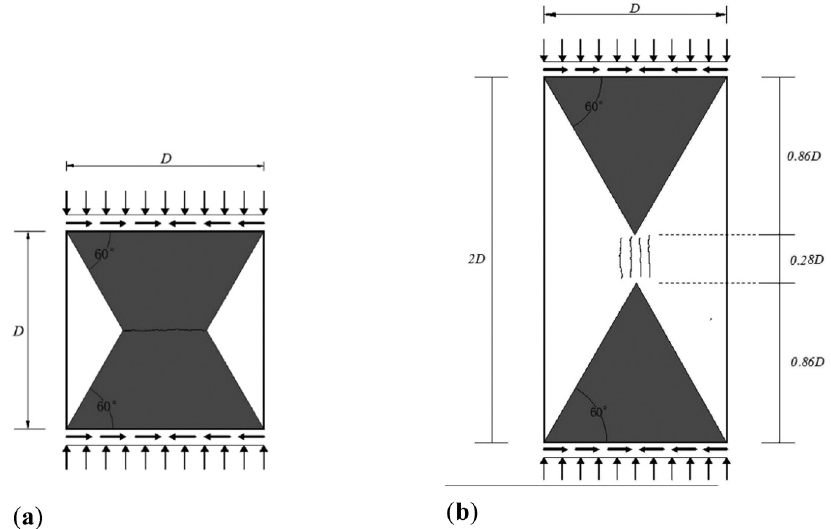
Figure 12: Stress distribution: ( a ) cubical specimen and ( b ) prism specimen.